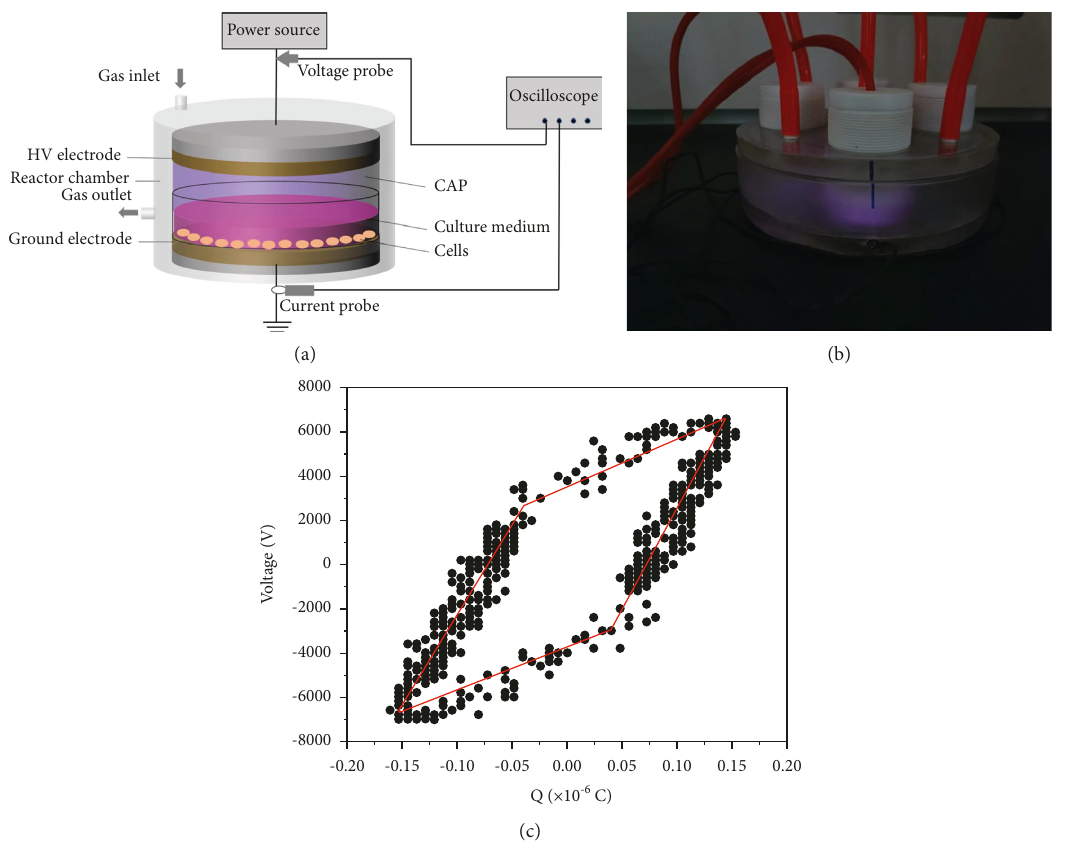
Figure 1: (a) Schematic diagram of the atmospheric pressure DBD plasma device. (b) Image of CAP that has been generated. (c) The V-Q Lissajous pattern of